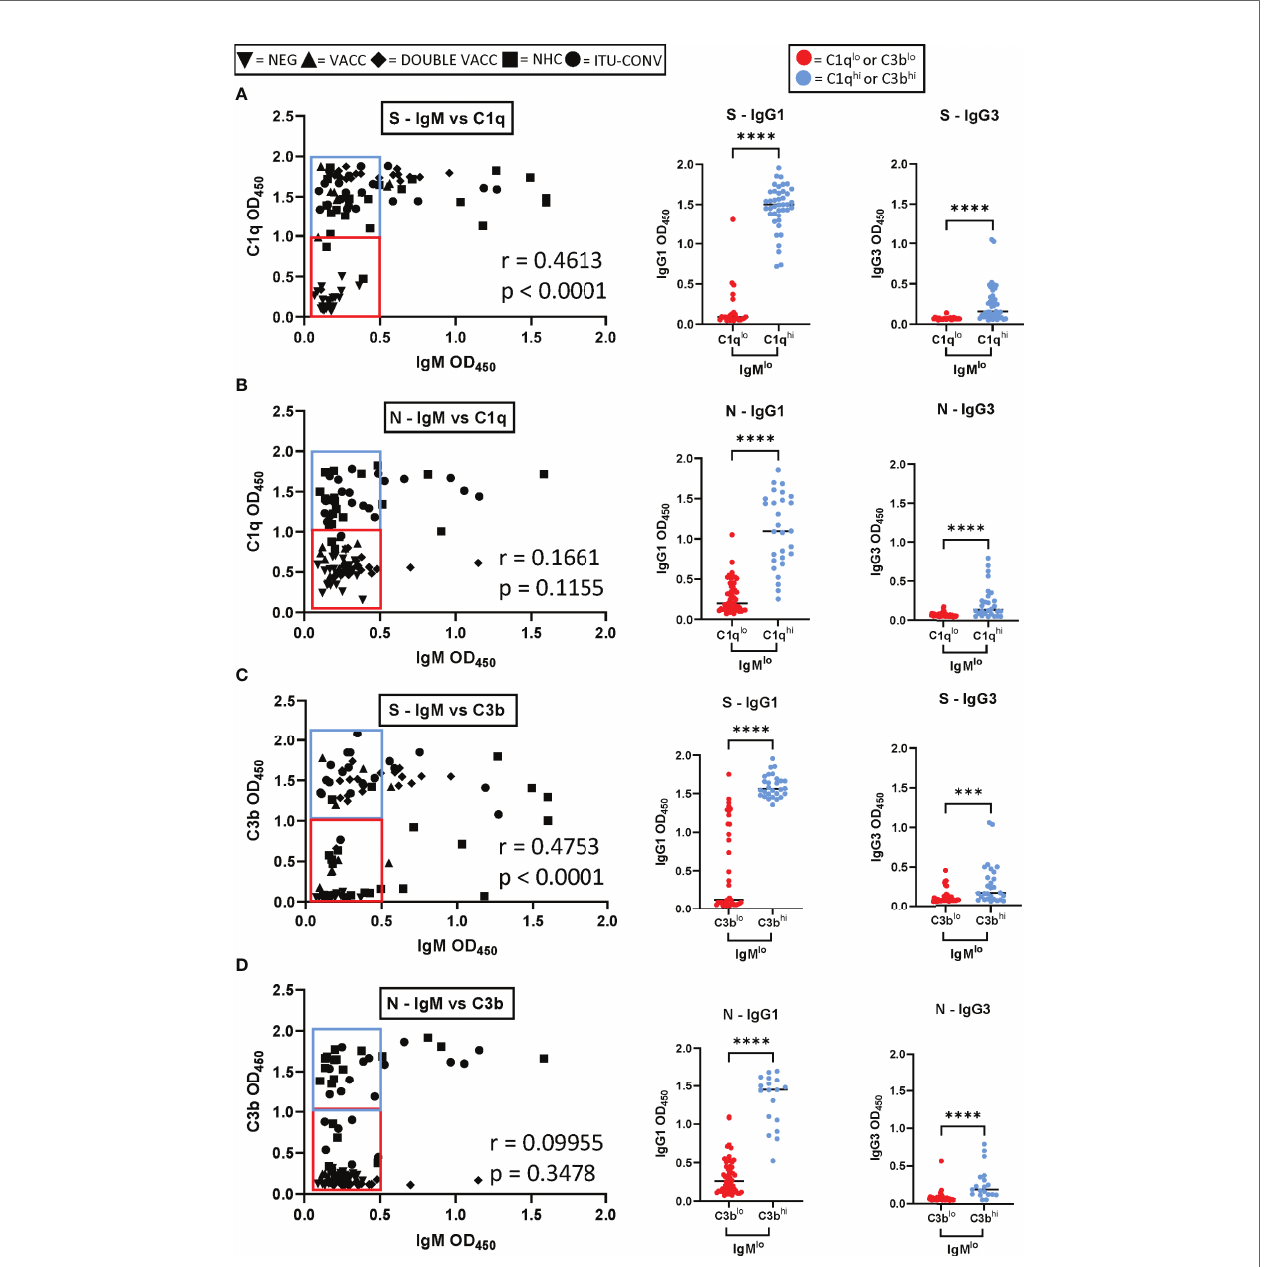
FIGURE 5 | Complement activation by sera with low levels of IgM to S and N. (A) Left hand panel shows the IgM levels plotted against levels of C1q for S (left hand panel; results for 91 sera presented from NEG, VACC, DOUBLE VACC, NHC and ITU-CONV donors). The IgG1 levels for sera presented in the blue box (IgM lo C1q hi ) or red box (IgM lo C1q lo ) are shown in the central graph and for IgG3 in the right hand graph (n ≥ 18 for each group). Each coloured dot represents one sera from the corresponding coloured box. (B) As for a, but the anti-N response is presented. (C, D) , as for (A, B) respectively but with the results for C3b binding shown rather than C1q. Correlations were determined using the Spearman ’ s rank correlation test (r and p values presented). Mann-Whitney was used to test signi fi cance in the IgG1 and IgG3 column graphs, where ****p < 0.0001 and ***p < 0.001. Bars represent median values for each